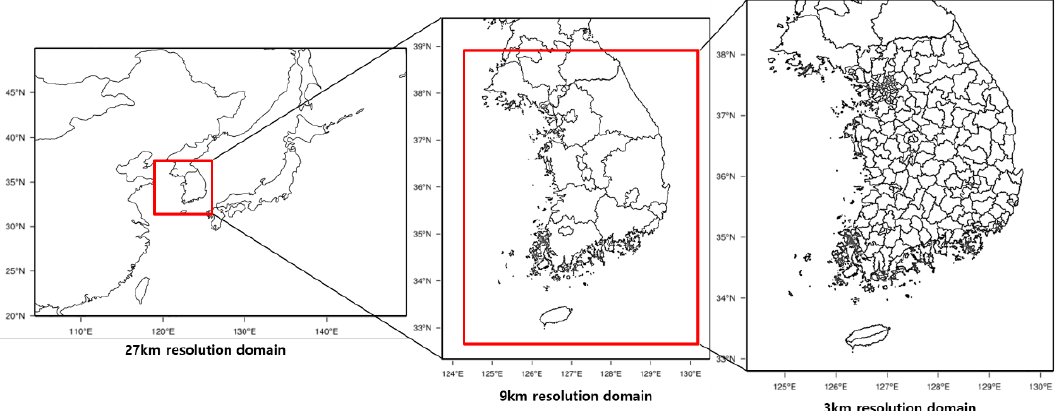
Figure 2. Modeling domains.